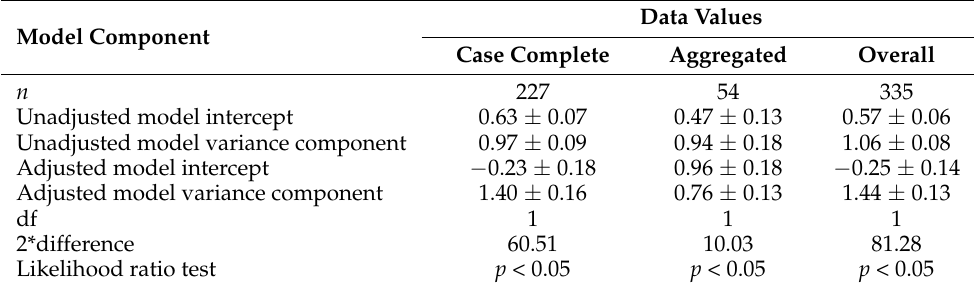
Table 2. Results from the Vevea and Hedges assessment of publication bias at the 0.05 cutpoint.